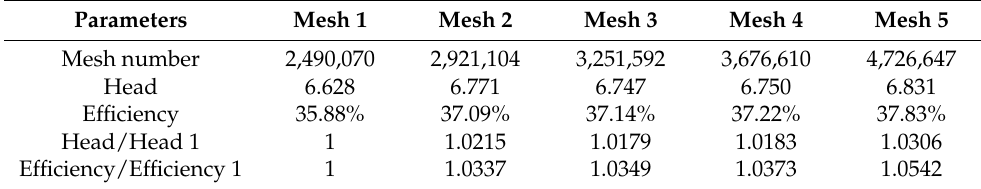
Table 1. Mesh independence verification.